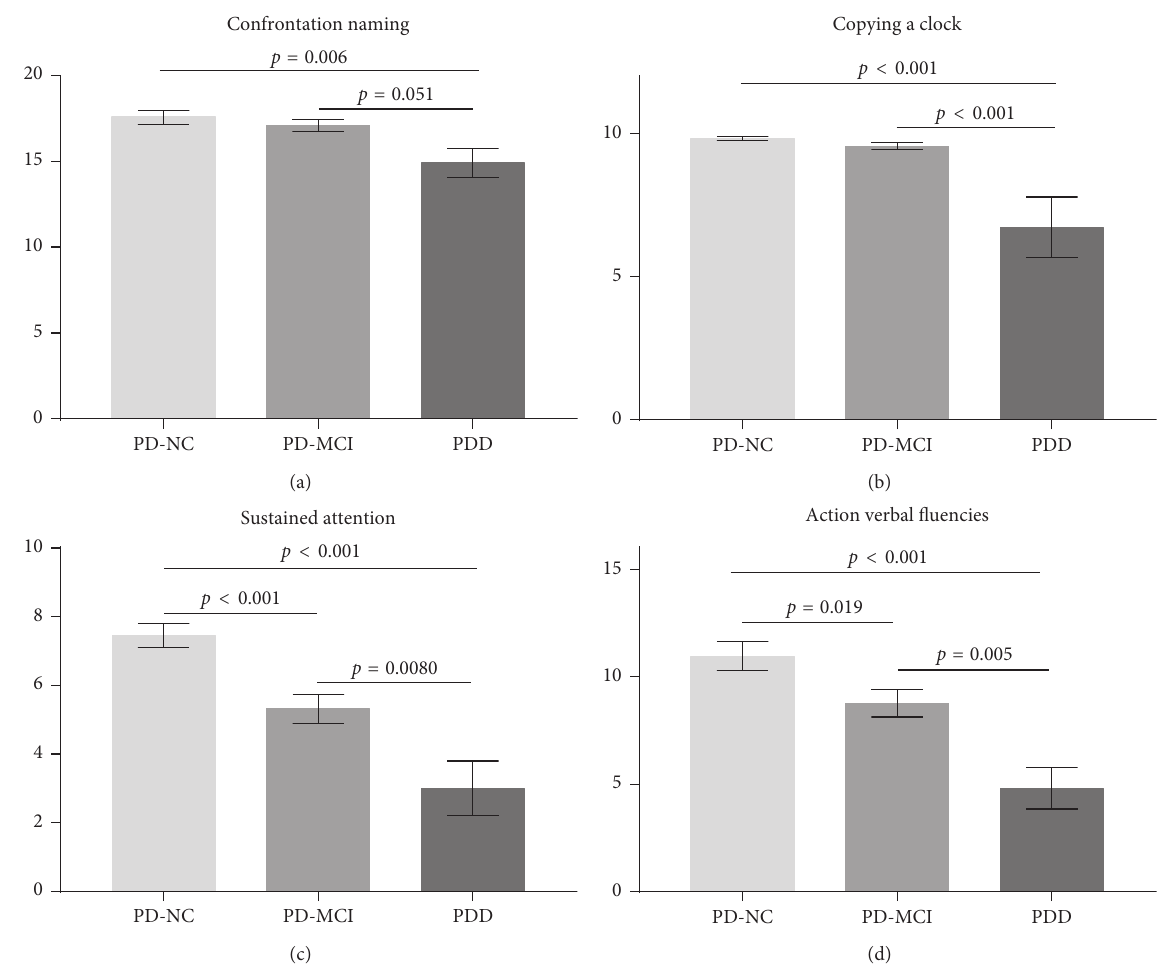
Figure 1: Comparative progression of impairment of “frontal-subcortical functions” and “instrumental-cortical functions” in PD-NC, PD- MCI, and PDD subgroups (mean ± SE). Cortical functions (confrontation naming and copying a clock) are relatively normal in PD-MCI, but had abrupt decline in the PDD group (a and b). Sustained attention and action verbal fluencies were used as examples to show marked decline of subcortical functions in both PD-MCI and PDD (c and